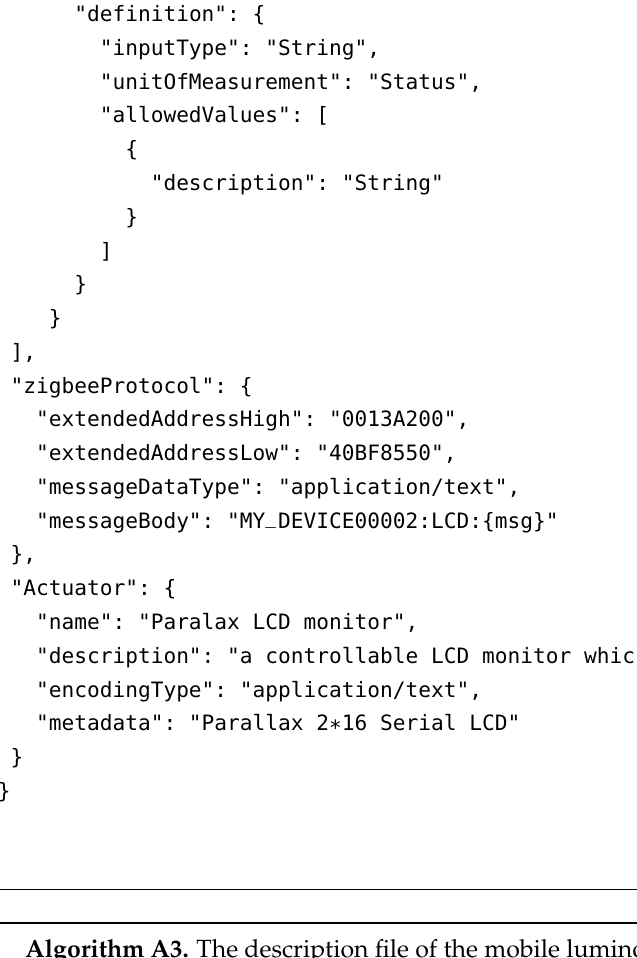
Algorithm A3. The description file of the mobile luminosity-monitoring